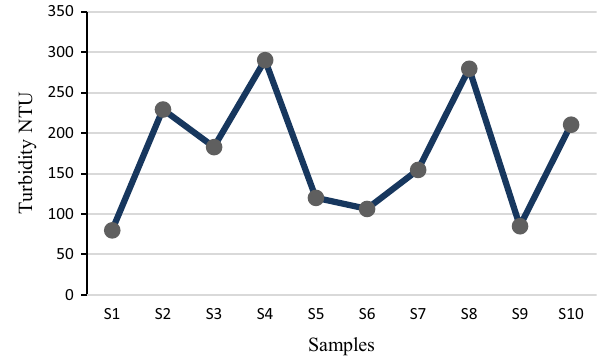
Fig. 3 Average pH values of analyzed dairy effluents